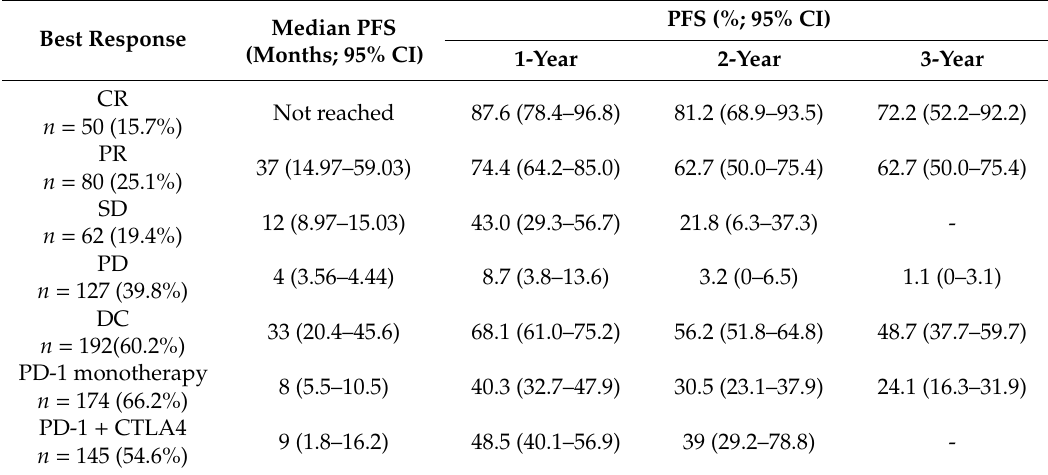
Table 3. Median progression-free survival and progression-free survival rates for patients receiving first-line PD-1-based immunotherapy according to best overall response and type of